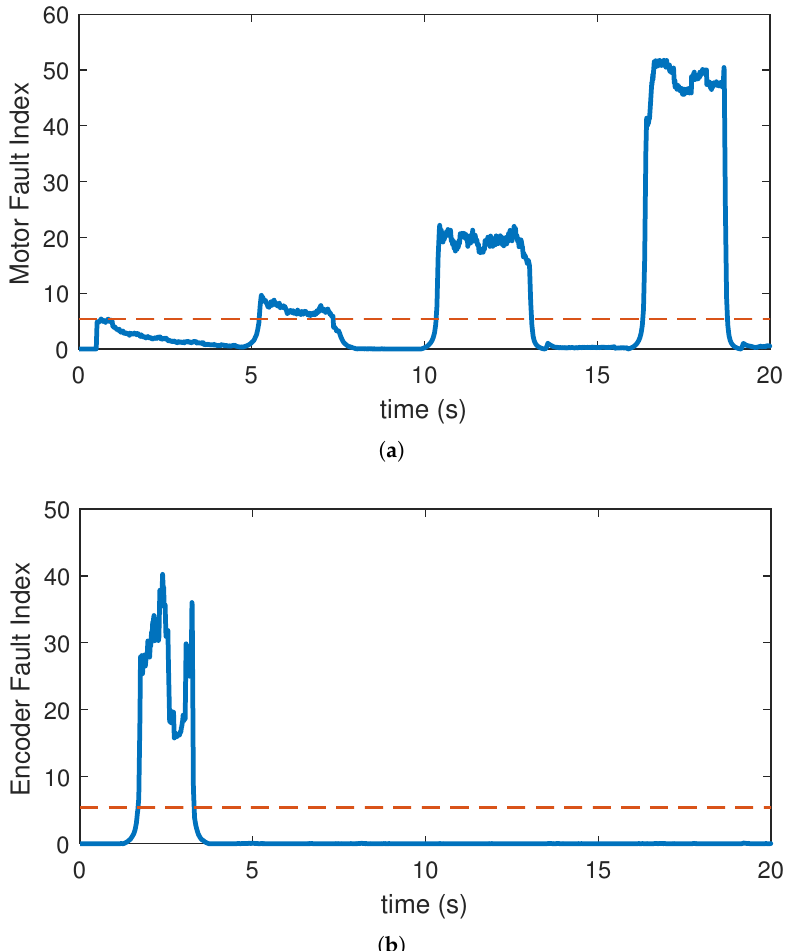
Figure 14. Test statistic for ITSC fault and encoder faults.